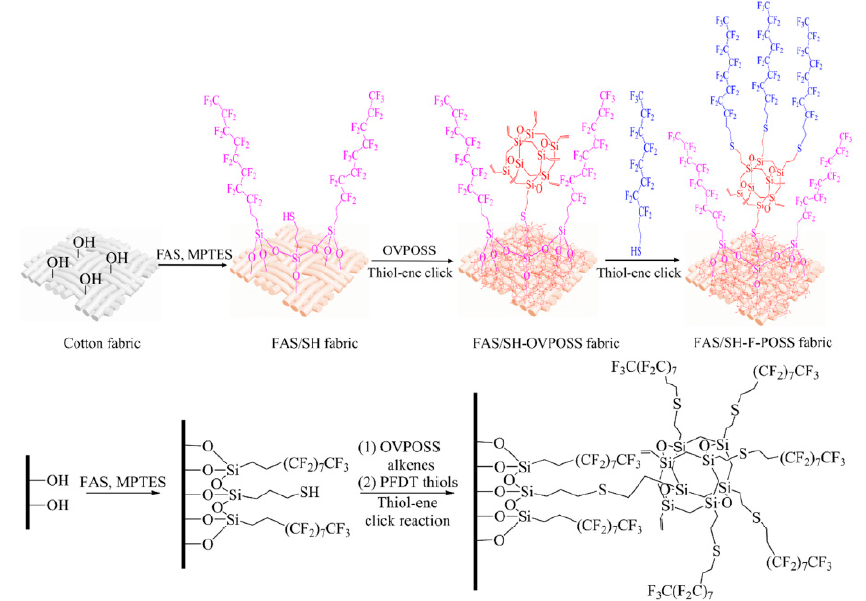
Figure 18. A schematic illustration of the procedure for preparing the FAS/SH-F-POSS coating on cotton fabric via silane coupling reaction and thiol-ene click reaction. Reproduced with permission from Ref. [65]. Copyright (2021), with permission from